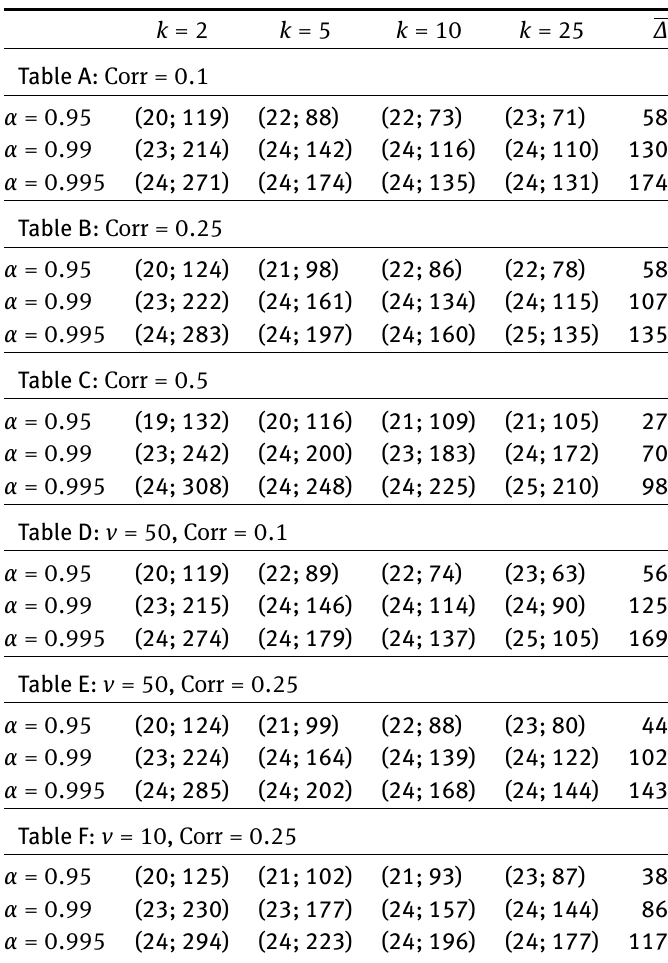
Table A: Corr = 0.1